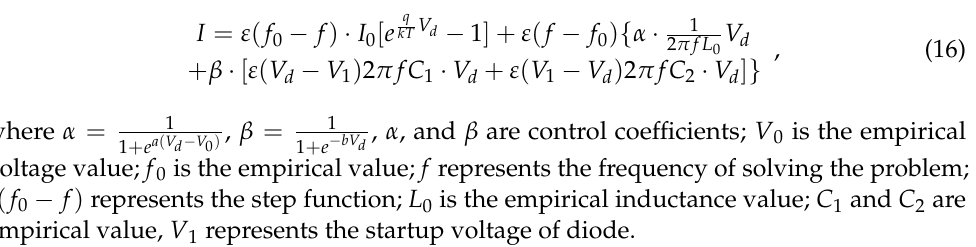
ε ( f 0 − f ) represents the step function; L 0 is the empirical inductance value; C 1 and C 2 are empirical value, V 1 represents the startup voltage of